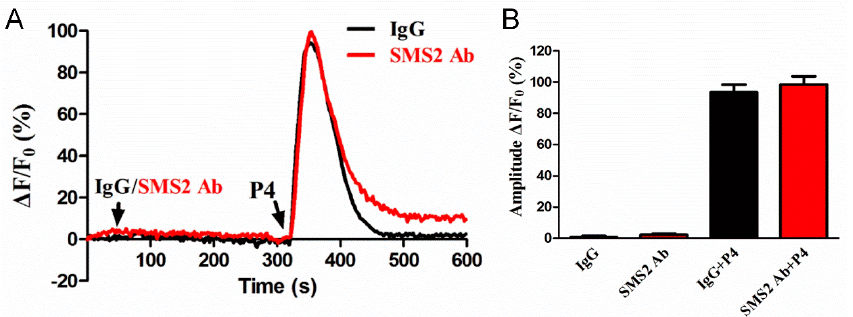
Figure 6. The e ff ect of SMS2 inhibition on sperm Ca 2 + signaling. ( A ) The e ff ects of SMS2 inhibition on Figure 6. The effect of SMS2 inhibition on sperm Ca 2+ signaling. ( A ) The effects of SMS2 inhibition on the time of maximum intracellular [Ca 2 + ]i; ( B ) the e ff ects of SMS2 inhibition on the ratio of ∆ F / the time of maximum intracellular [Ca 2+ ]i; ( B ) the effects of SMS2 inhibition on the ratio of Δ F/F0.